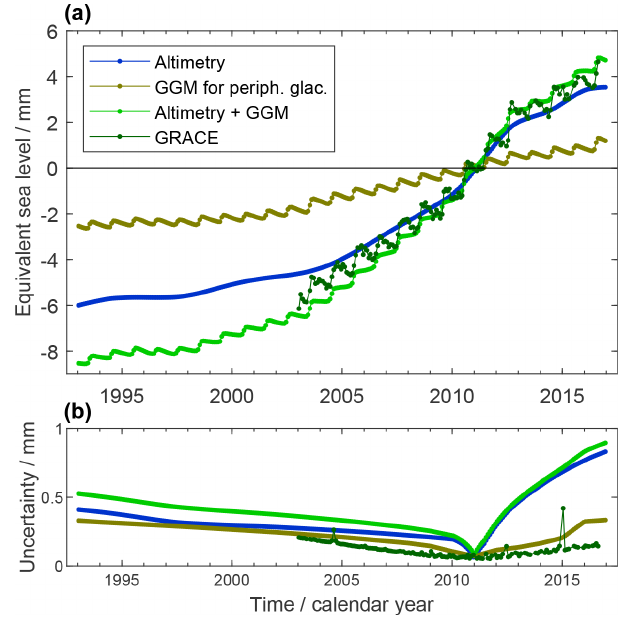
Figure 6. (a) Greenland ice-mass contribution to GMSL assessed from GRACE (dark green) and from the combination of altime- try and GGM (light green). The altimetry-based assessment for the ice sheet (blue) and the GGM-based assessment for the periph- eral glaciers (brown) are also shown. Ice-mass change is expressed in terms of equivalent GMSL change with respect to the mean of the reference interval of 2006–2015. GRACE-based time series are shown in their original temporal sampling where some months are missing. (b) Uncertainties assessed for the estimates in (a)